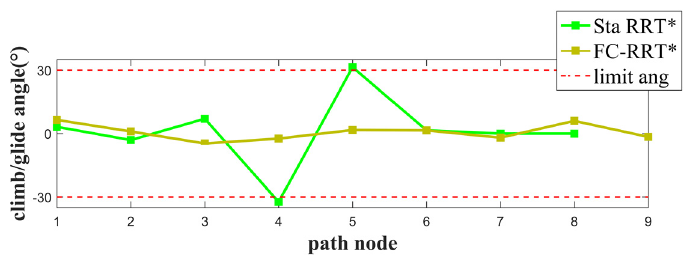
Figure 12. The climbing/gliding angle comparison between FC-RRT* and RRT*.